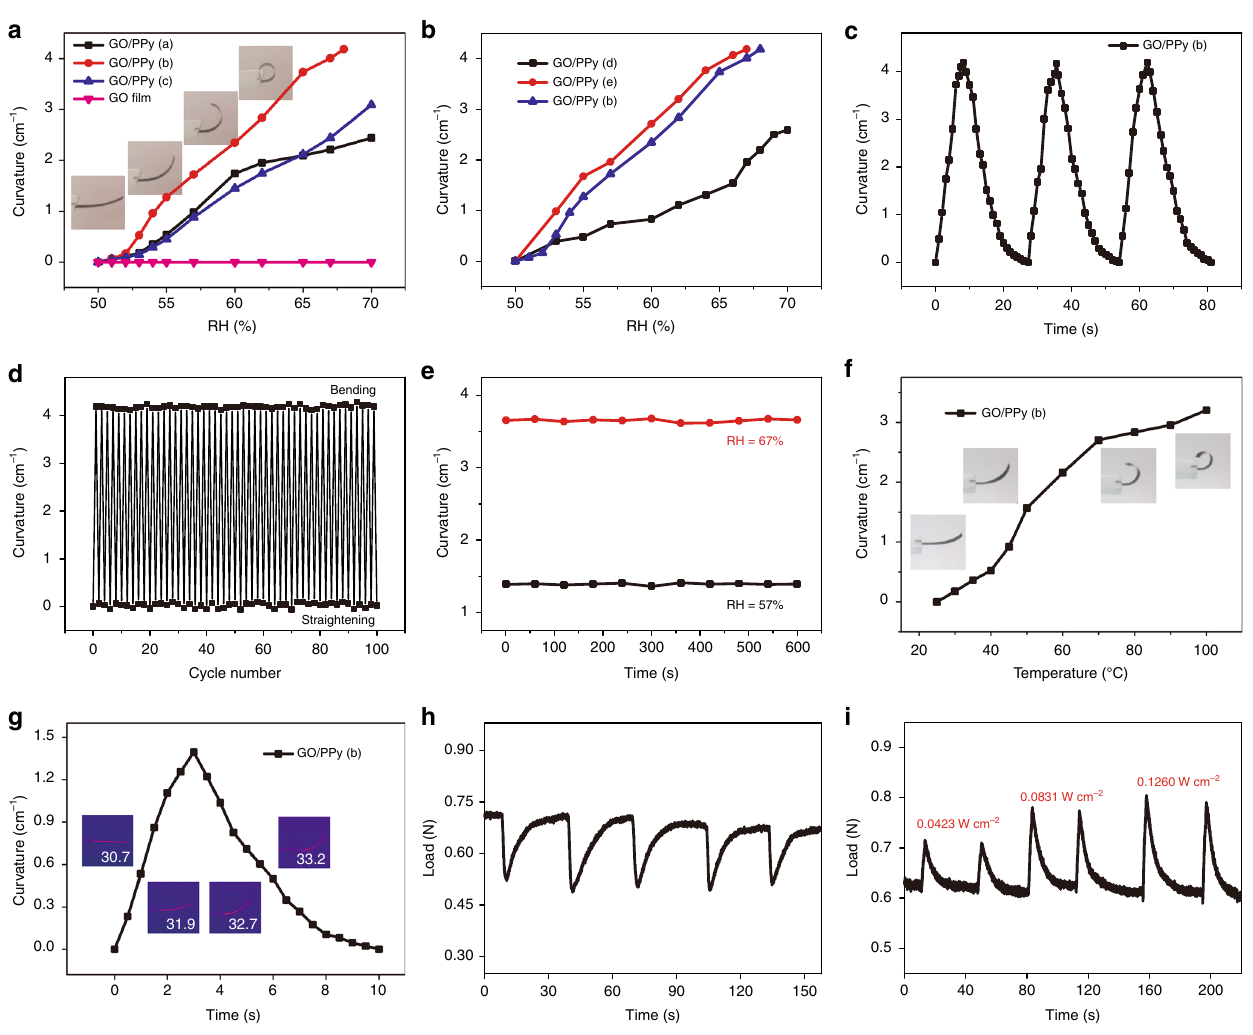
Fig. 3 Actuating performance of GO/PPy actuator. a Actuating performance of GO/PPy actuators under the stimulus of humidity, (GO/PPy ( a ), GO/PPy ( b ) and GO/PPy ( c ) represent GO/PPy actuators with different GO thicknesses of 12.8, 25.2 and 37.1 μ m, respectively) (the insets are photographs of the bending GO/PPy ribbon under different RH values); b Actuating performance of GO/PPy actuators under the stimulus of humidity, (GO/PPy ( d ), GO/PPy ( e ) and GO/PPy ( b ) represent GO/PPy actuators with increasing PPy thicknesses and same GO thickness of 25.2 μ m; c switching from the bent to the straight state of GO/PPy ( b ) by changing the corresponding RH from 50 to 68%, and vice versa; d cyclic stability of the curvature of a GO/PPy actuator over 100 cycles (50 – 68% RH); e durable behavior of GO/PPy ( b ) after exposure to 57% or 67% RH for 600 s; f actuating performance of GO/PPy ( b ) under the stimulus of temperature (the insets are photographs of the bending GO/PPy ribbon at temperatures of 25, 50 and 100 °C); g actuating performance of GO/PPy ( b ) under the stimulus of IR light (the insets are photographs of the bending GO/PPy ( b ) at different times); h the bending force of GO/PPy ( b ) actuator recorded during the process of turning on/off the humidi fi er; i the contractile force of GO/PPy ( b ) actuator recorded during the process of turning on/off IR light with power densities of 0.0423, 0.0831 and 0.126 W cm − 2 (from left to